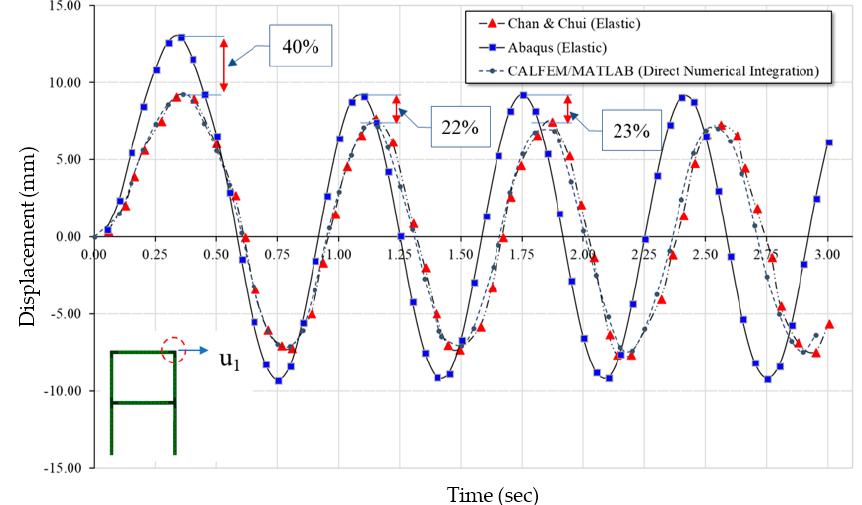
Figure 15. Elastic analysis dynamic response ABAQUS, Chan and Chui [15] and CALFEM/MATLAB.